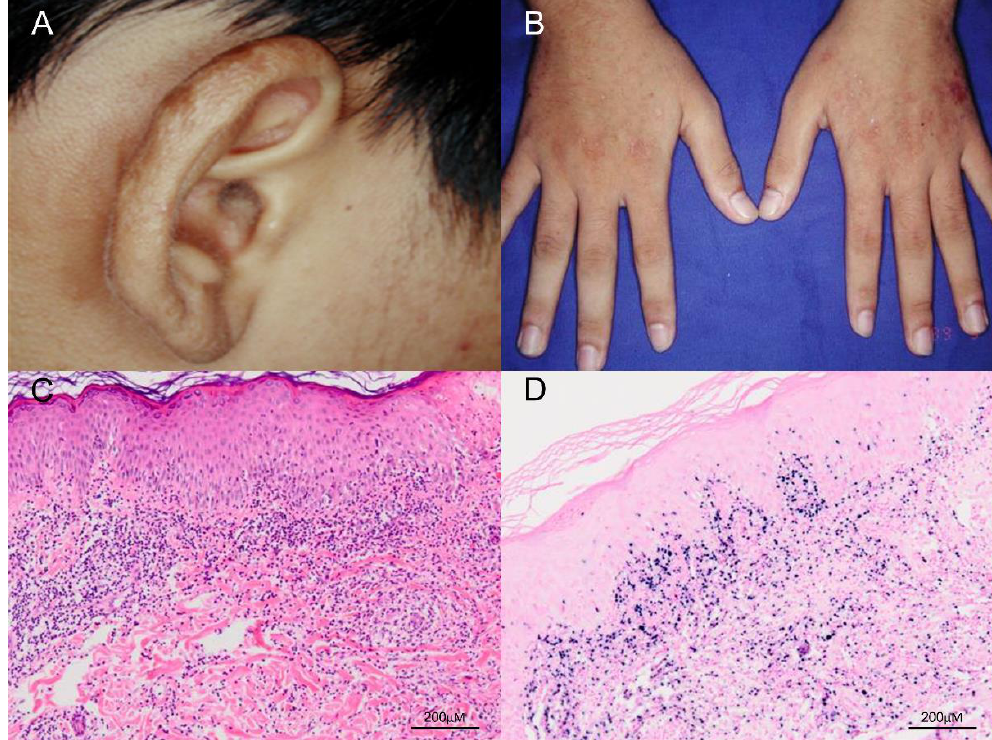
Figure 2. Clinical and pathologic features of classic HV. ( A , B ) The patient was a 17-year-old boy who presented with multiple papulovesicular eruptions, crusting and scarring over the earlobes, face and the dorsum of both hands for 4–5 years. The lesions were exacerbated in summer. ( C ) Histological examination of the skin biopsy specimen shows a dense lymphocytic infiltrate, mostly confined to the upper dermis, and composed of small lymphoid cells with minimal atypia (H&E, 100×). Scale bar = 200 μM. ( D ) In situ hybridization for Epstein–Barr virus–encoded small RNA (EBER) shows numerous positive cells in the skin (EBER, 100×). Scale bar = 200 μM.